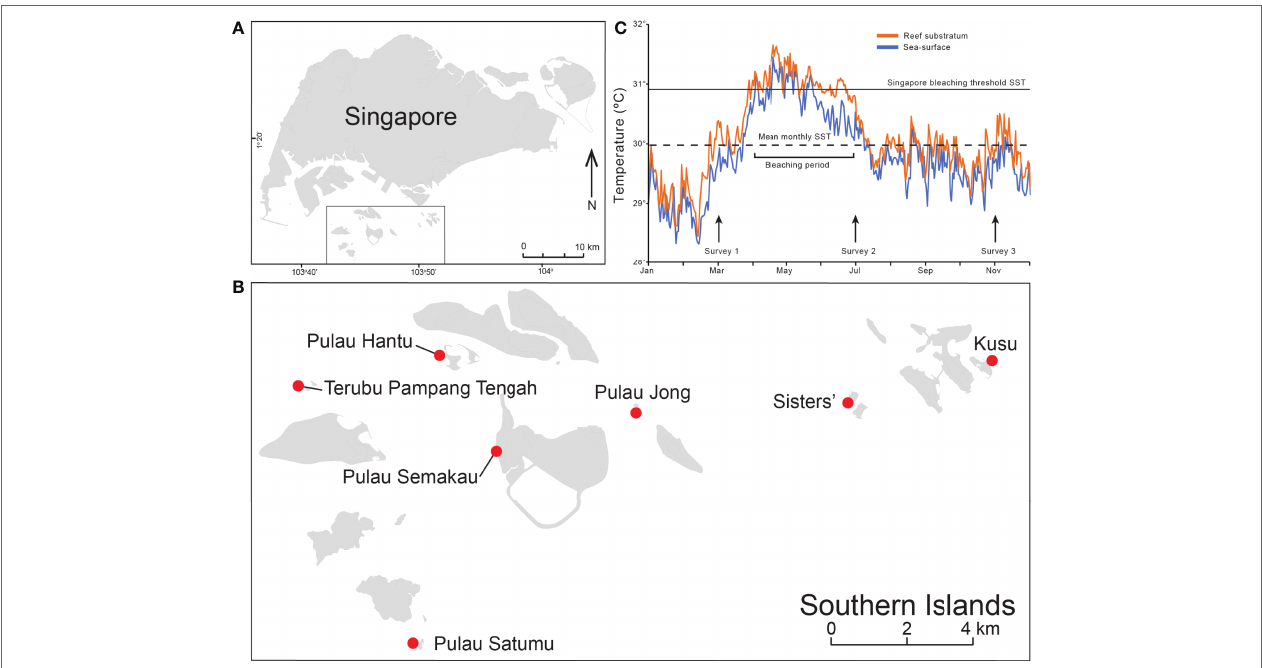
FIGURE 1 | National setting showing (A) Singapore and (B) and the seven reefs sites in the Southern Islands (from west to east: Terumbu Pempang Tengah (TPT), Pulau Satumu, Pulau Hantu, Pulau Semakau, Pulau Jong, Sisters’ and Kusu. (C) In situ water temperature data (orange) and satellite derived sea-surface temperature (SST) data (blue) for Singapore recorded from 1/01/16 to 12/31/16). Data extracted from the NOAA Coral Reef Watch (https://coralreefwatch.noaa.gov/ product/vs/gauges/singapore.php). Arrows indicate the three survey periods in March, July and November